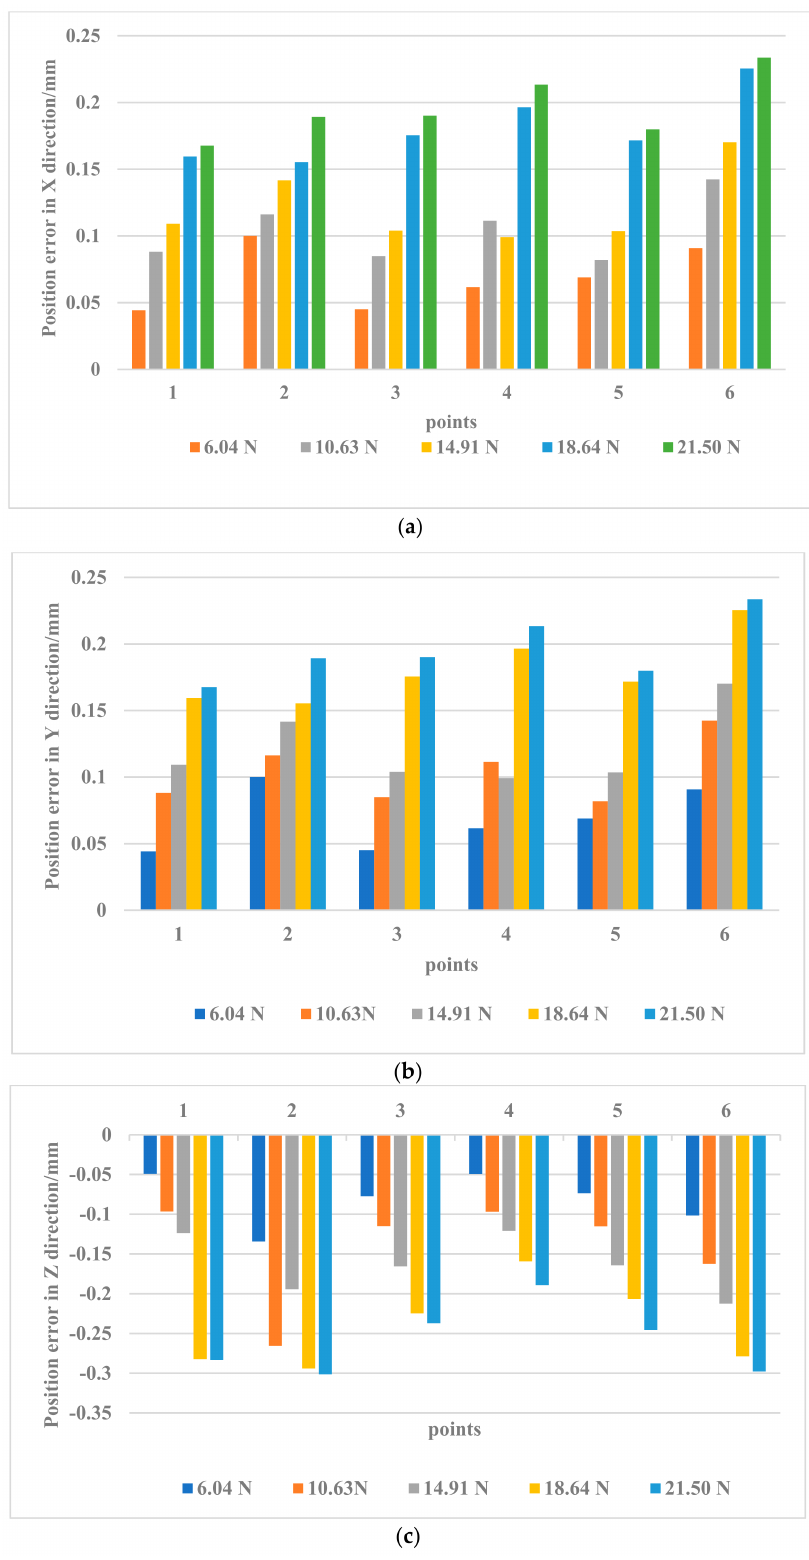
Figure 11. Position error in ( a ) X, ( b ) Y, ( c ) Z direction under different